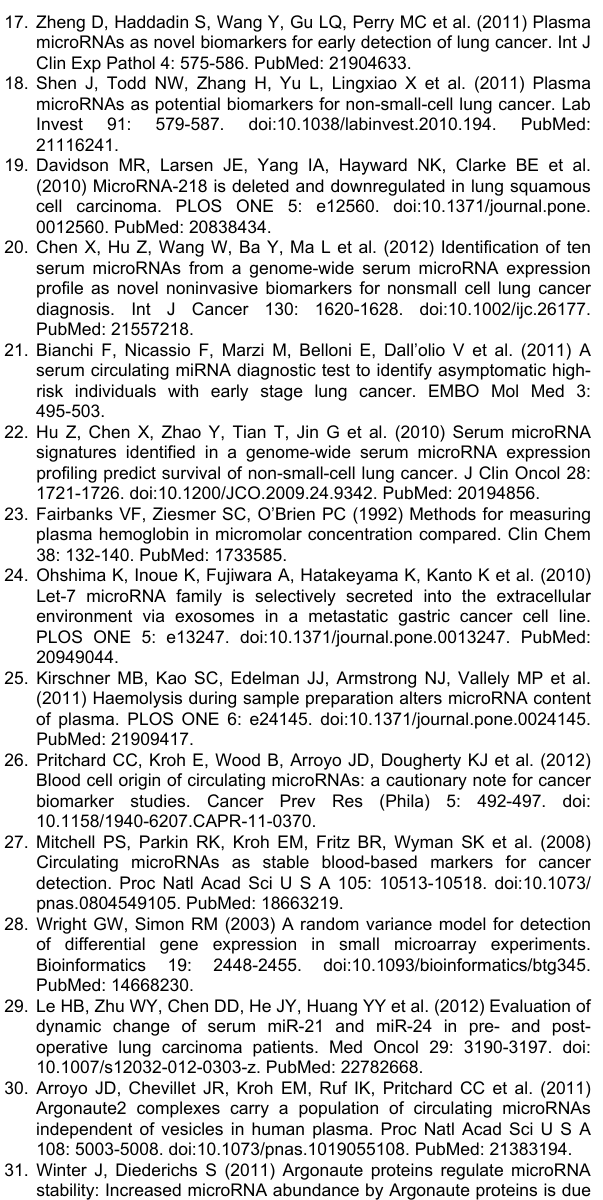
Table S2. Results of additional validation for selected miRNAs. Mean Ct values are shown for pre- and post- operative samples. “-” indicates no detection